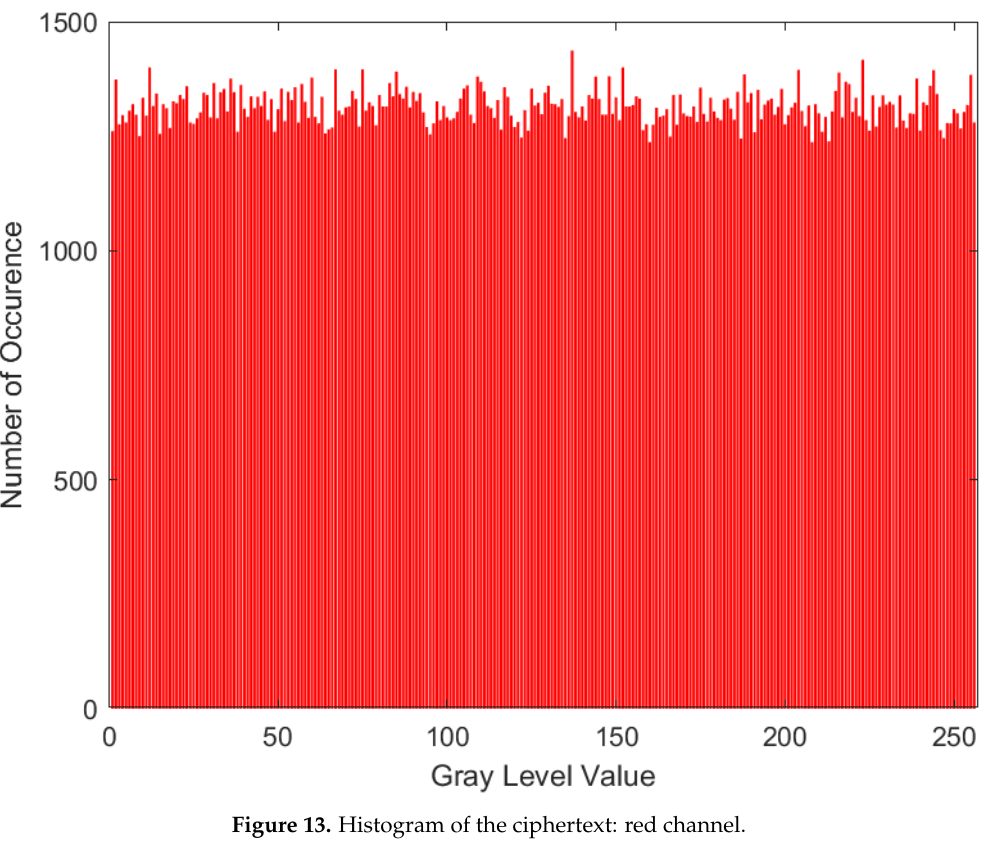
Figure 13. Histogram of the ciphertext: red channel.